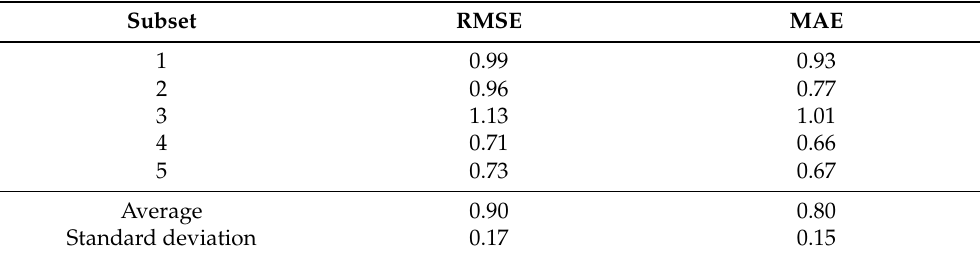
Table 3. Results of the metrics with K-fold cross-validation method.